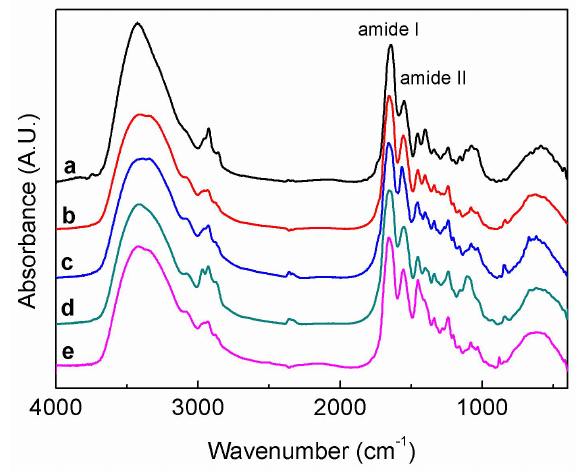
Figure 6. FTIR spectra of native collagen ( a ), and collagen cross-linked by the SiO 2 /DAC hybrid materials: collagen cross-linked by DAC ( b ); collagen cross-linked by SiO 2 /DAC (1/10) ( c ); collagen cross-linked by SiO 2 /DAC (1/2) ( d ); and collagen cross-linked by SiO 2 ( e ).